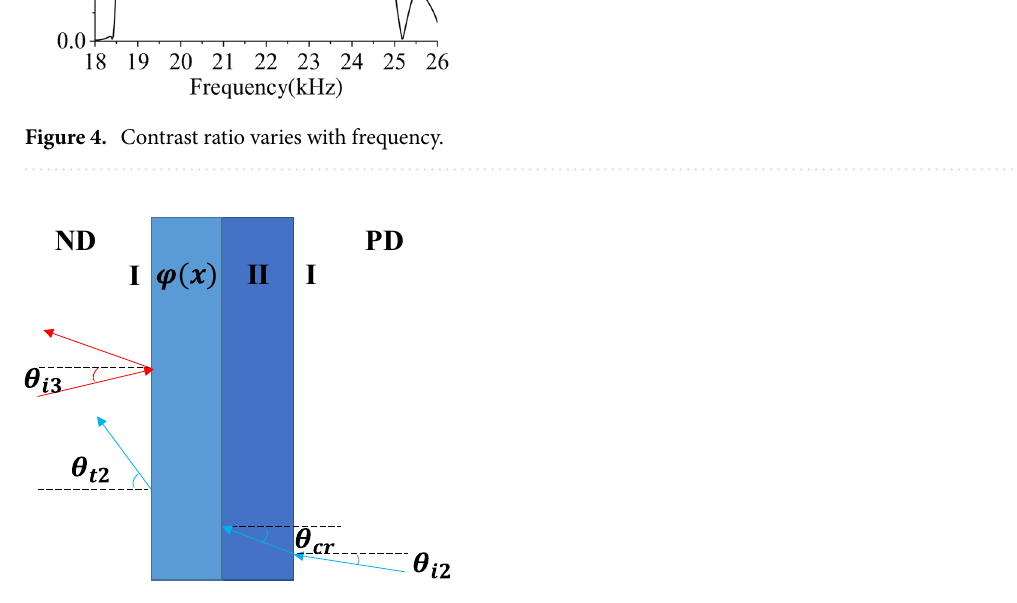
Figure 5. Schematic diagram of asymmetric transmission structure with oblique incidence. The blue path and the red path are the trajectories of the incident waves from PD and ND